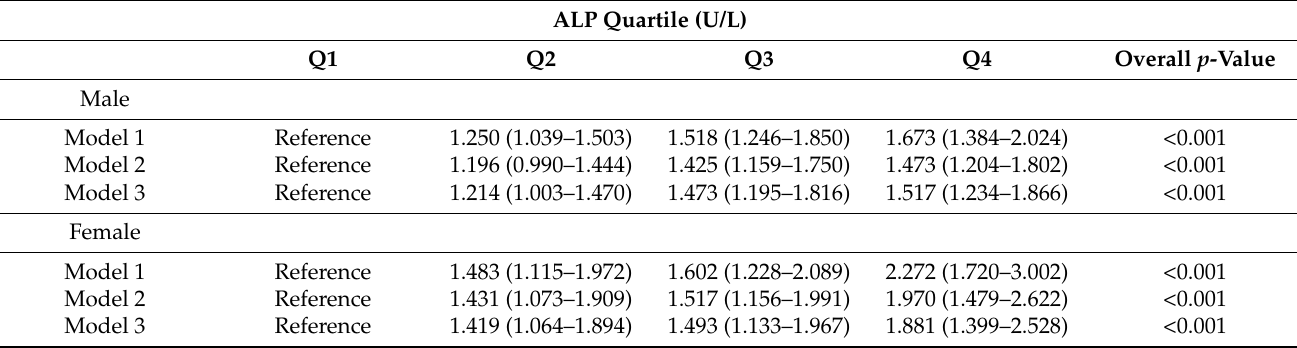
Table 2. Odds ratios and 95% confidence intervals for high TG/HDL ratio according to serum ALP.